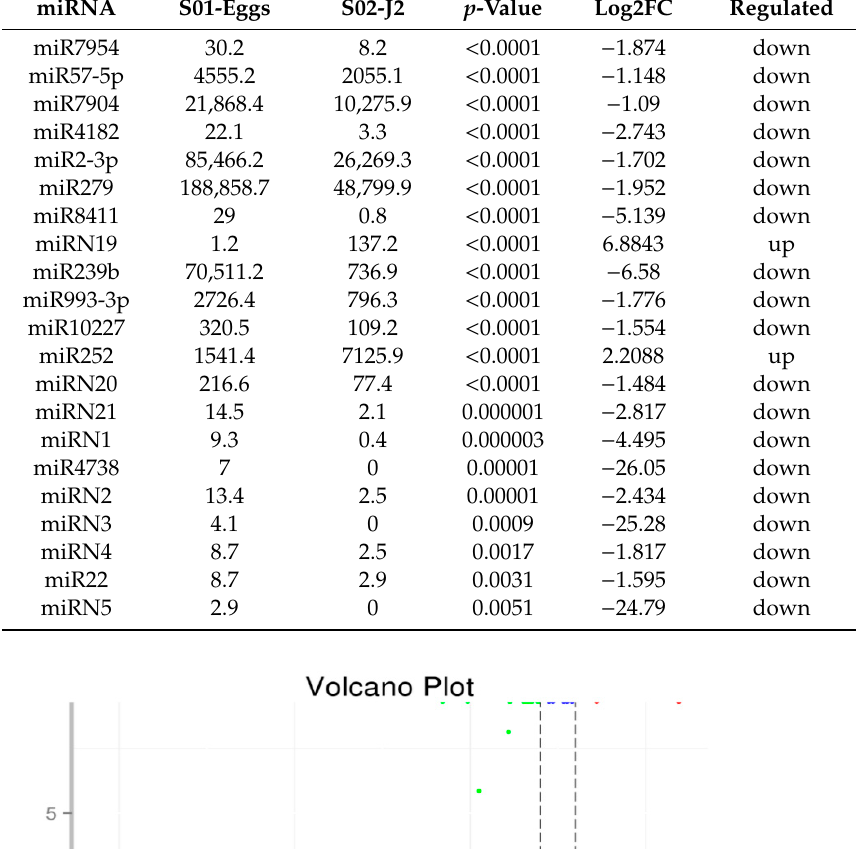
Table 4. Di ff erentially expressed miRNAs between RKN eggs and J2 larvae.